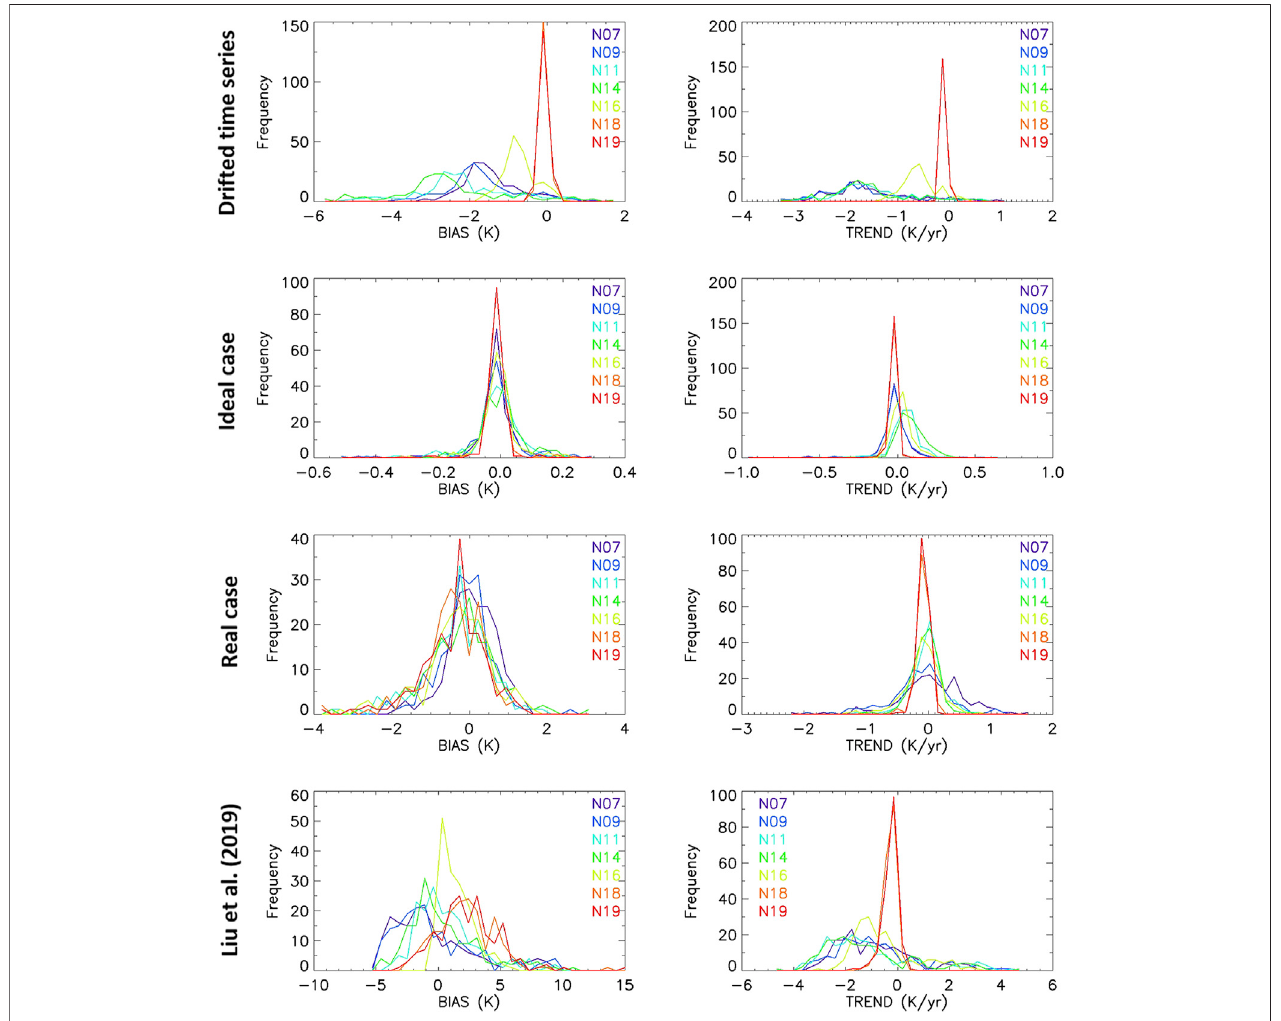
FIGURE 8 | Histogram ofbiasand trend differencestatisticsfor drifted time series, aswellasideal,realcase, andLiu etal. (2019)correctionsfor eachNOAAplatform.